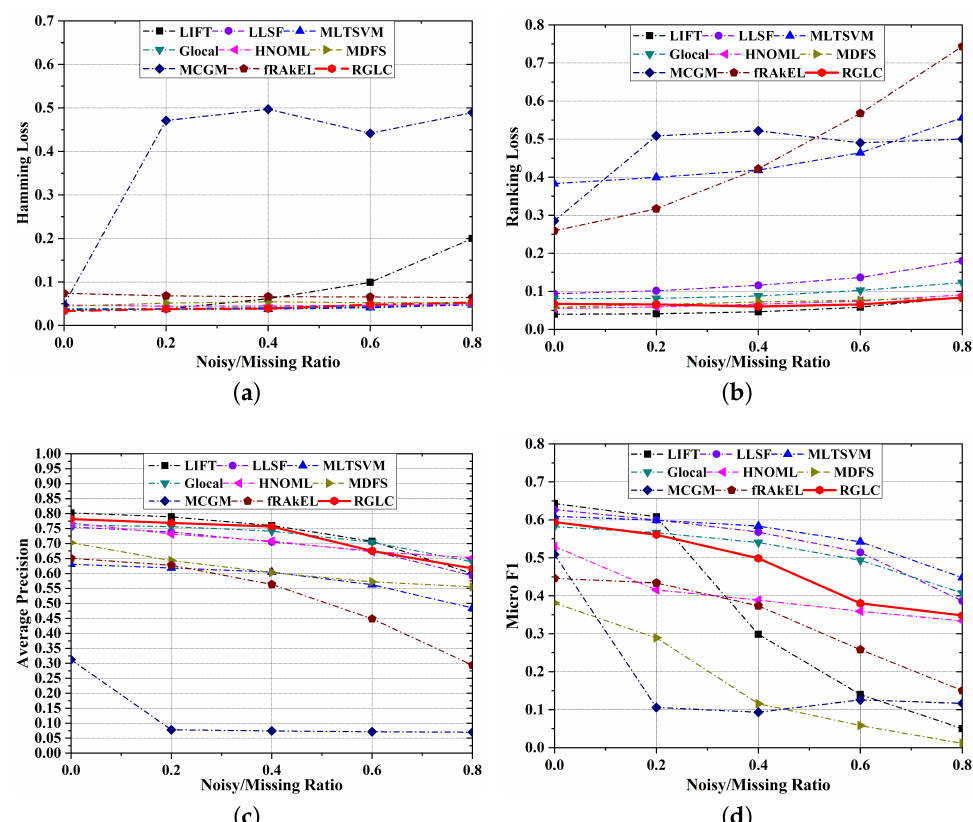
Figure 4. Robustness experiments with noisy features and missing labels on dataset health on metric ( a ) Hamming Loss , ( b ) Ranking Loss , ( c ) Average Precision , and ( d ) Micro F1 .